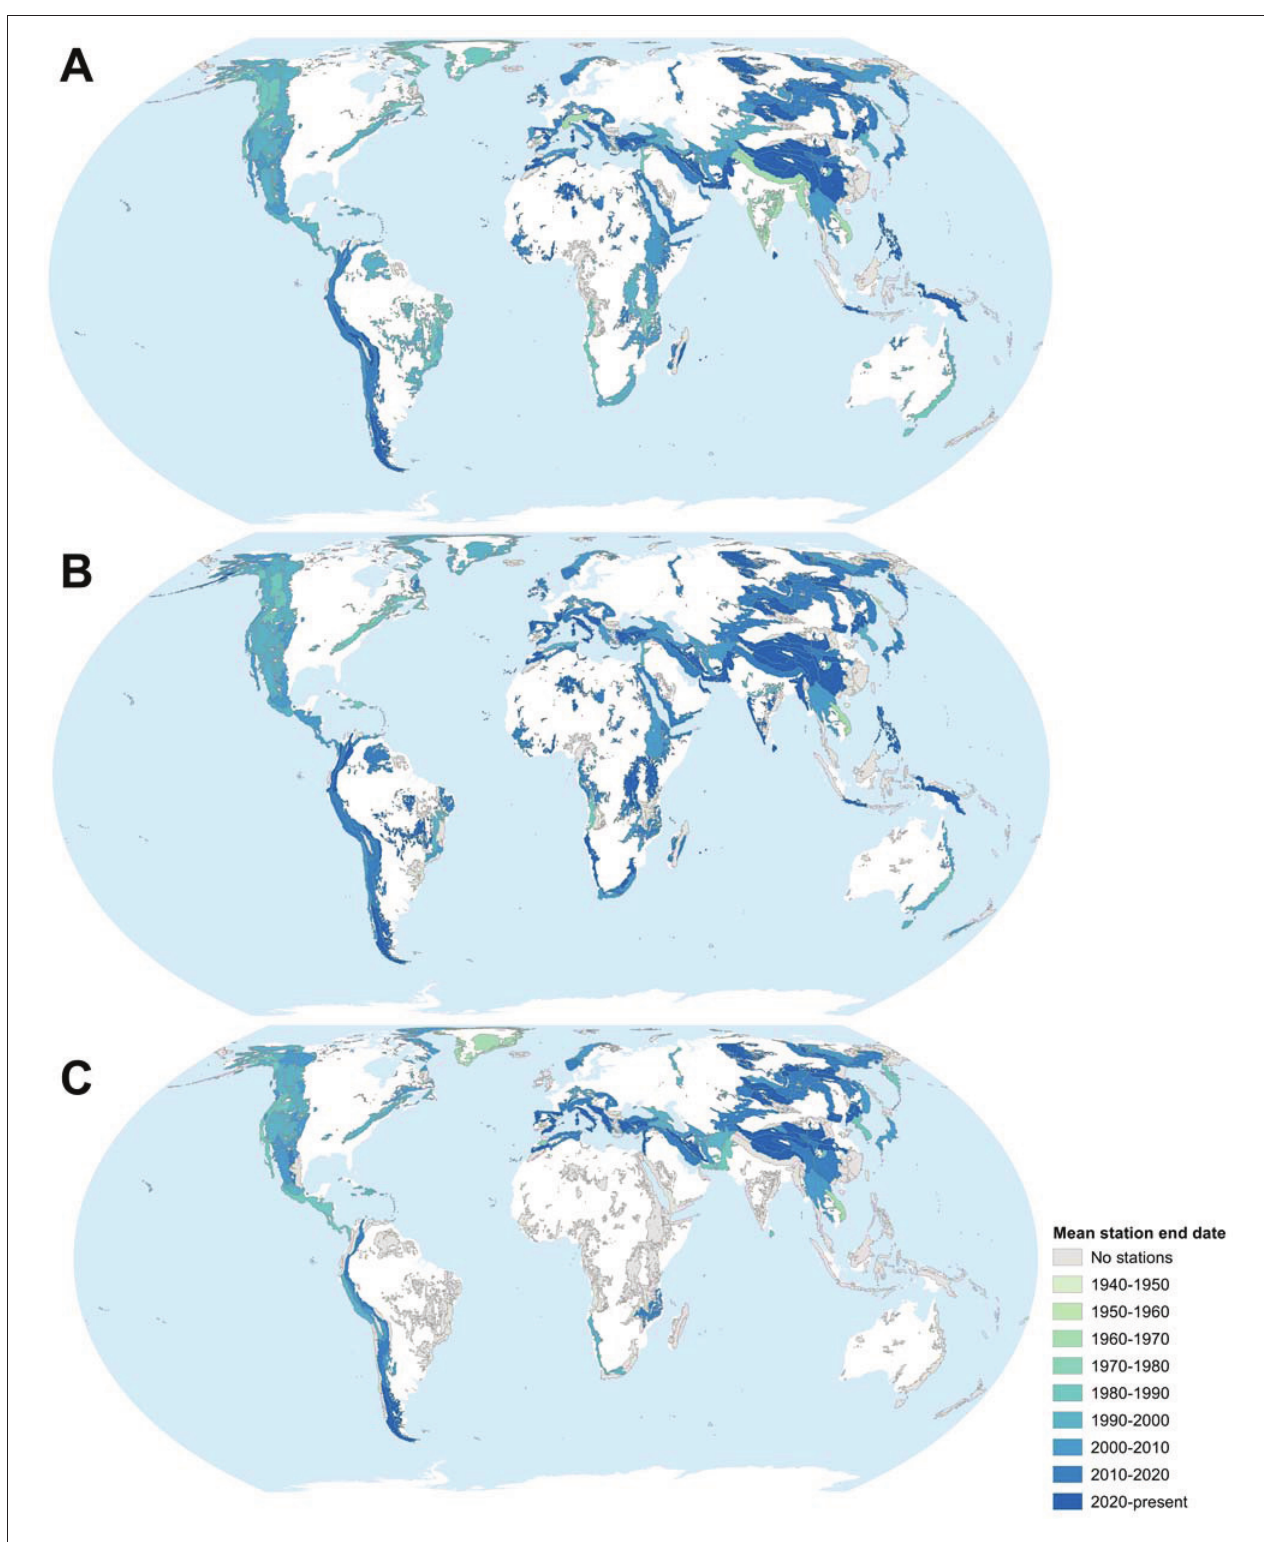
FIGURE 6 | Mean record end date of GHCNd stations in mountainous terrain for PRCP (A) , TMAX (B) , and SNWD (C) by GMBA mountain polygon. The corresponding plot for TMIN is provided in the online Supplementary Material. Whilst the entire GMBA regions are shown, the statistics plotted correspond to only the mountainous parts of these regions, as delineated by Kapos et al. (2000).